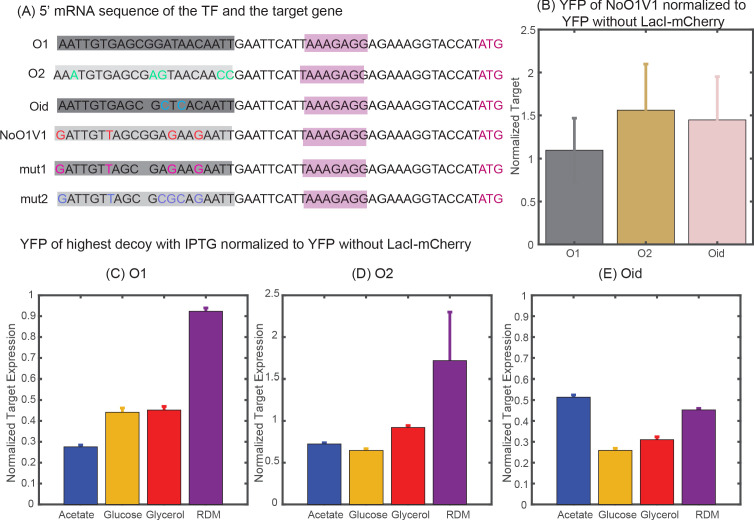
Determining constitutive expression of YFP and mCherry.(A) 5′ mRNA sequence of the TF and the target genes. The binding site for the TF is carried in the mRNA sequence and is highlighted in shaded dark grey boxes with base changes for different binding sites coded in multicolor. mut1 and mut2 are the two variant binding sites that are designed with mutations similar to NoO1V1 but with Oid site length. However, such changes do not achieve constitutive unregulated expression similar to O2 or Oid. (B) Plot showing YFP expressed from NoO1V1 regulated promoter normalized to YFP expressed from promoter regulated with O1, O2 or Oid. (C-E) Plot showing the effect of 2.5 mM IPTG in relieving YFP expression form O1 (C), O2 (D) or Oid. (E) Regulated promoter and with 5X decoy plasmids. As indicated in the plot IPTG is not sufficient to restore complete expression of YFP in different media and hence cannot be used as a measure of constitutive expression.